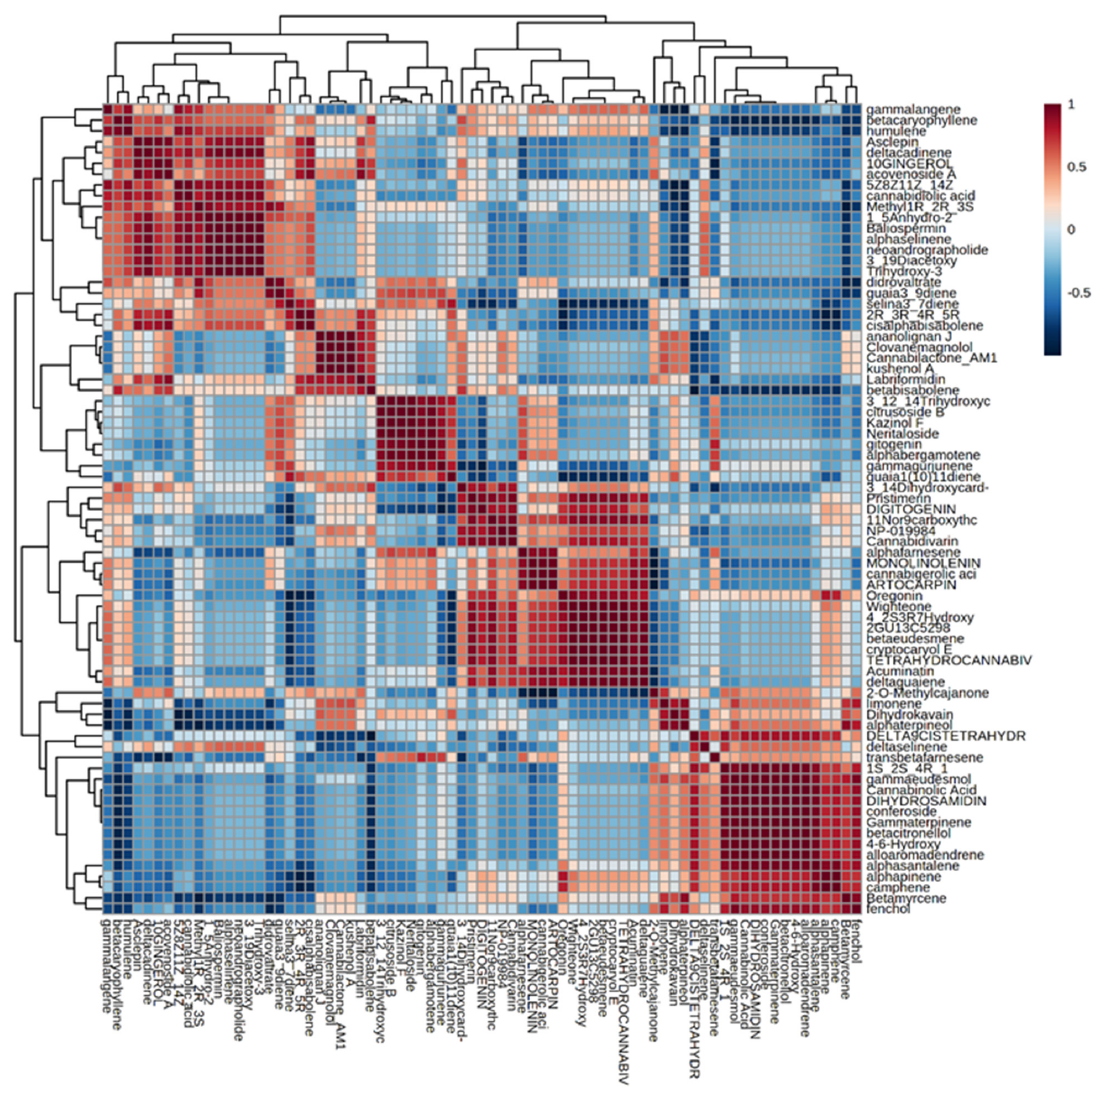
Figure 4. Correlation matrix. Correlation matrix based on Pearson Correlation coefficient among different volatile and non-volatile compounds of C. sativa inflorescences with dendrogram.